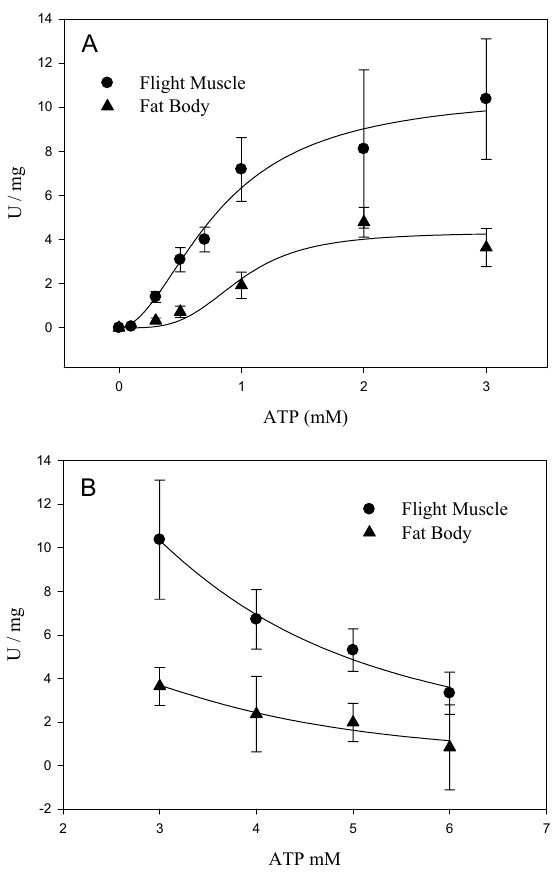
Fig. 3 – Effects of high and low ATP concentrations on PFK activ- ity from fat body and muscle homogenates. PFK activity of flight muscle (filled triangles) or fat body (filled triangles) was measured as described on Materials and Methods, in the presence of 5 mM fruc- tose 6-phosphate and different ATP concentrations. Panel A shows the activation exerted by lower ATP concentrations. Panel B shows the inhibition promoted by higher ATP levels. Values are means ± SE of at least six independent